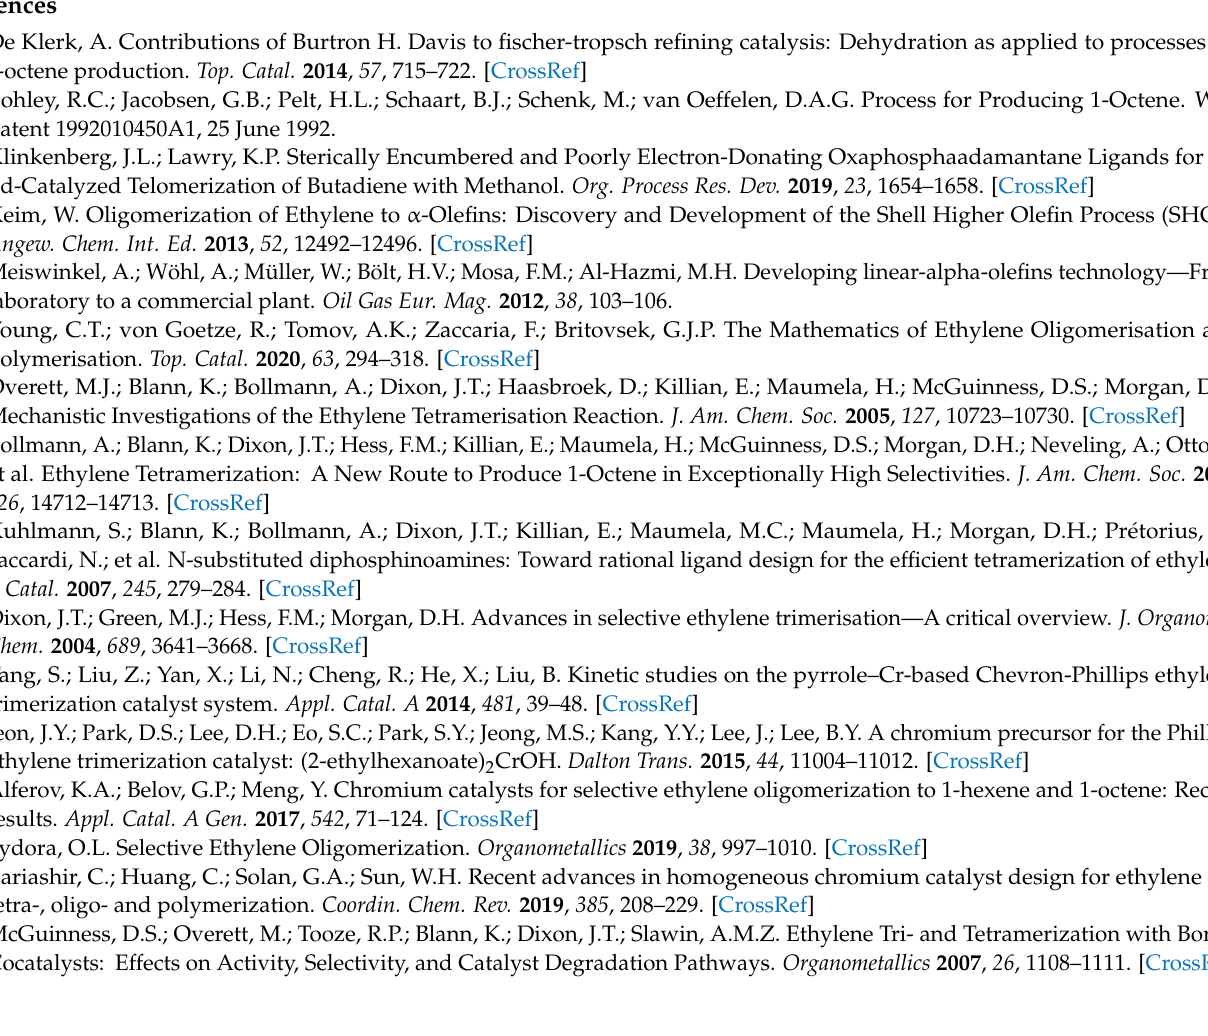
Figure S26: 1 H and 13 C NMR spectra of 2-Et-6-Me-C 6 H 3 N(PAr 2 ) 2 (Ar = − C 6 H 4 - p -Si(nBu) 3 ), Figure S27: 1 H and 13 C NMR spectra of iPrN(H)PAr 2 (Ar = − C 6 H 4 - p -Si(1-decyl) 3 ), Figure S28: 1 H and 13 C NMR spectra of iPrN(PPh 2 )(PAr 2 ) (Ar = − C 6 H 4 - p -Si(1-decyl) 3 ), Figure S29: 1 H and 13 C NMR spectra of ortho -C 6 H 4 N(PPh 2 ) (PAr 2 ) (Ar = − C 6 H 4 - p -Si(1-octyl) 3